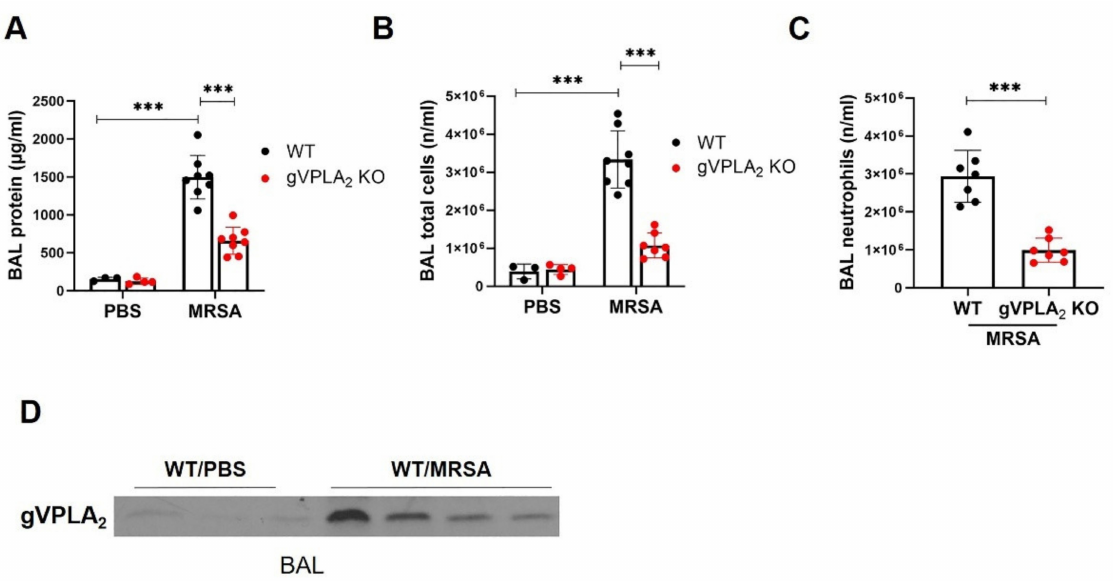
Figure 6. gVPLA 2 -deficient mice are protected from MRSA-induced lung injury. C57BL/6 (WT) and gVPLA 2 knockout (gVPLA 2 KO) mice were treated with live MRSA-USA300 (0.75 × 10 8 CFU/mouse) or PBS intratracheally. After 18 h, ( A ) total protein, ( B ) total cell counts, and ( C ) neutrophil counts were assessed in the bronchoalveolar lavage (BAL). ( D ): gVPLA 2 levels in BAL fluid were assessed by immunoblotting. *** p < 0.001. n = 3–8 mice/condition.